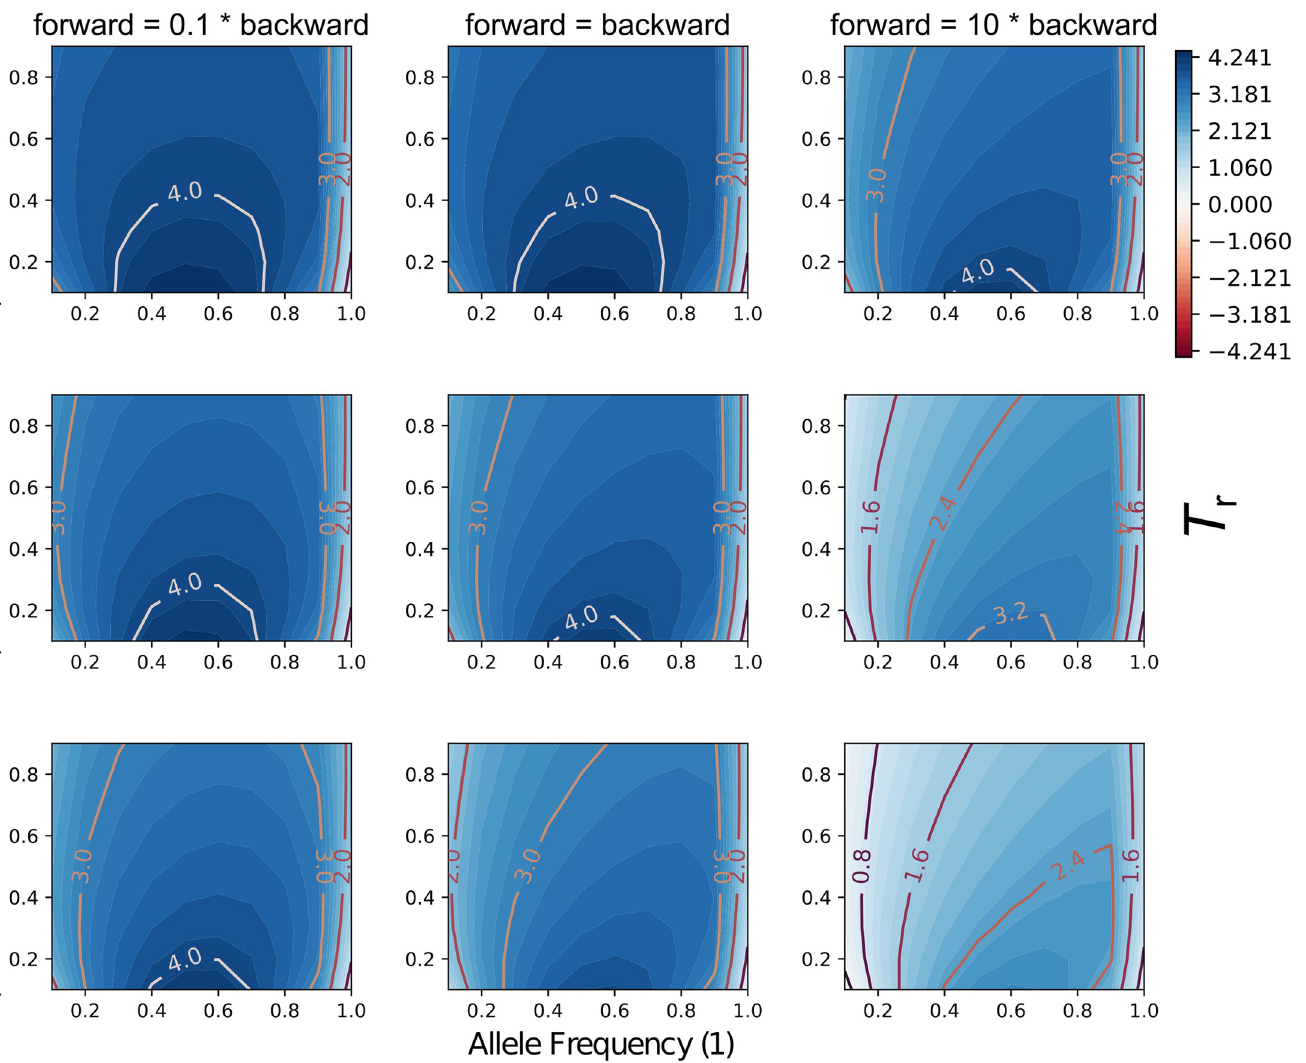
Fig 3. The interaction of evolutionary parameters affects the need for introgression to explain observed state counts. The x- and y-axis in each panel correspond to the frequency of character state 1 in taxon B and the reticulation time T . Columns correspond to three different relative forward/backward character substitution r rates and rows correspond to three different population mutation rates. In all panels T 2 − T 1 = 10 coalescent units and γ =